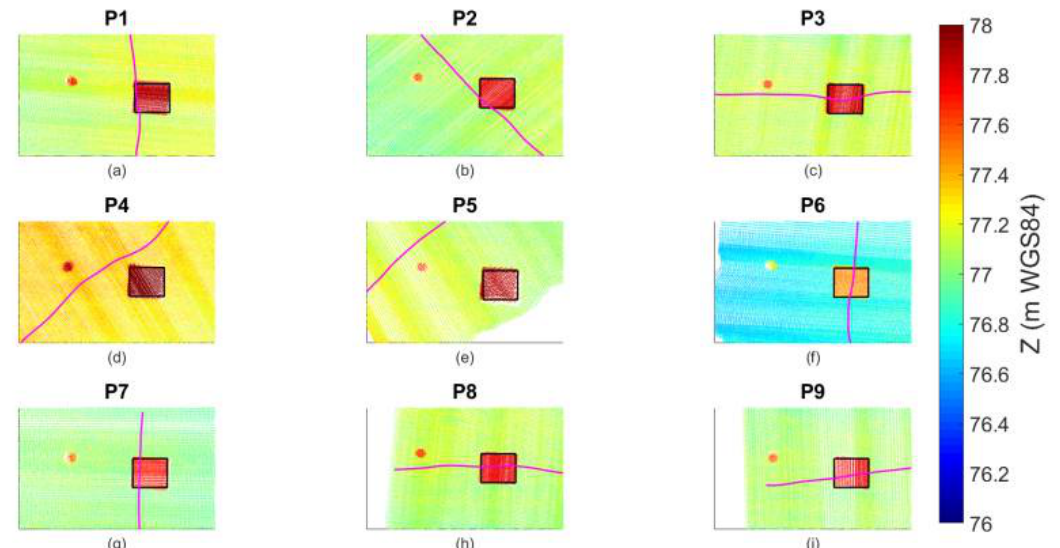
Figure 9. The target identified from each point cloud of the nine passages. The bar represents the values of the ellipsoidal height, with higher values shown in red. The fuchsia lines represent the UAV flight tracks.